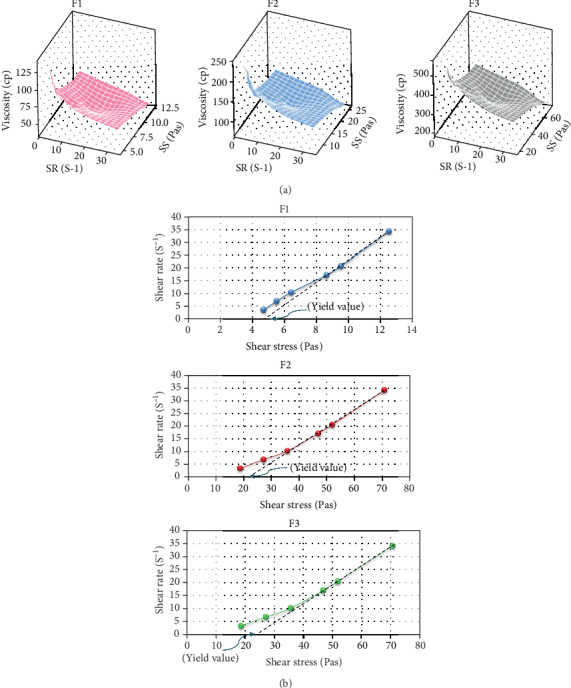
(a) 3D-surface plot of viscosity and shear stress as a function of shear rate for F1, F2, and F3. The graph was prepared by Minitab® 19. (b) Rheograms of the sol systems (F1, F2, and F3); the viscosity is given as a mean ± SD (n = 3) at 25°C.